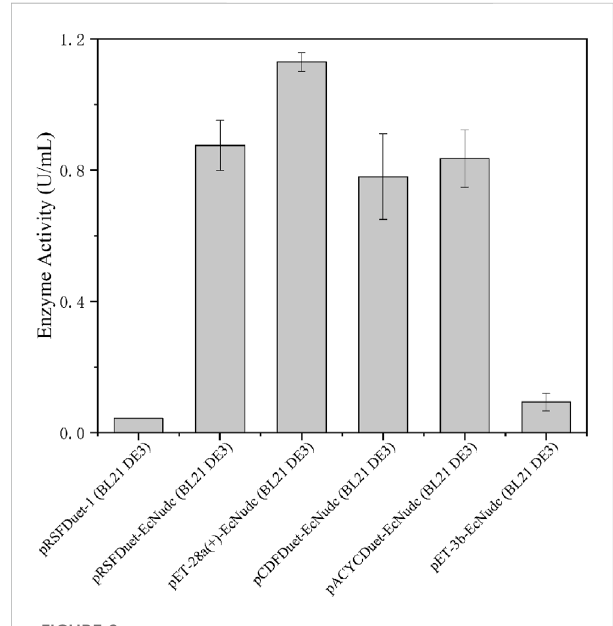
FIGURE 2 Screening of EcNudc expression